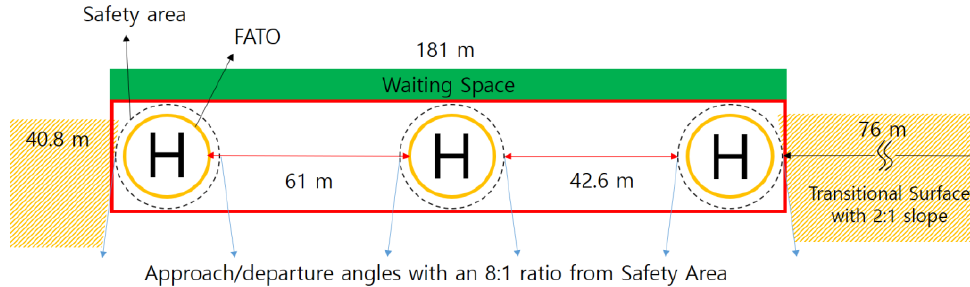
Figure 10. Example of linear topology that complies with the EASA’s new regulations.